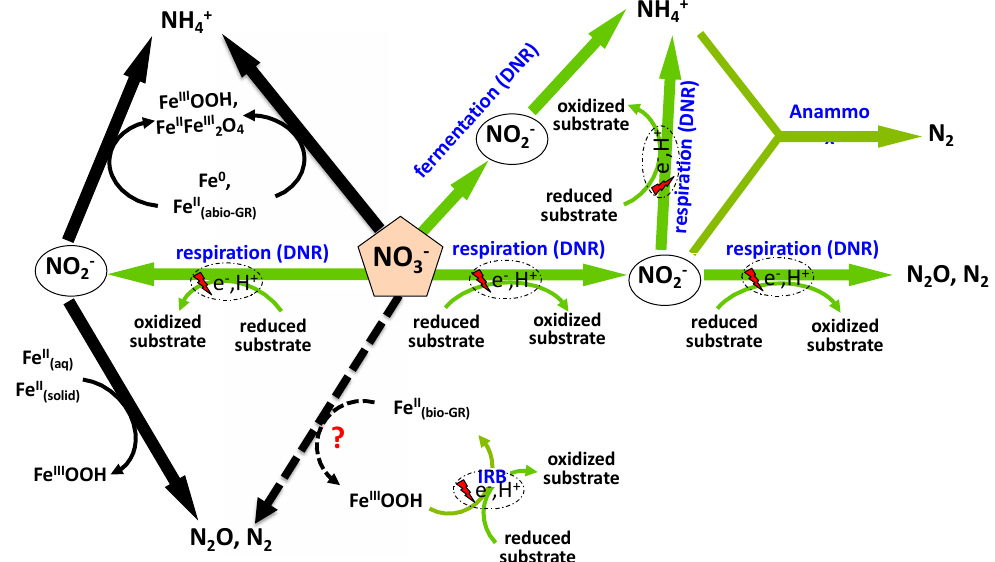
Figure 1. Conceptual diagram of the major biotic and abiotic processes involved in nitrogen reduction. Green and black arrows represent biotic and abiotic reactions, respectively. IRB: iron-respiring bacteria, Fe III OOH: ferric oxyhydroxides, Fe II Fe III 2 O 4 : magnetite, Fe II (abio-GR) : abiotic green rust, Fe II (bio-GR) : biogenic hydroxycarbonate green rust, reduced substrate: organic or inorganic electron donors,